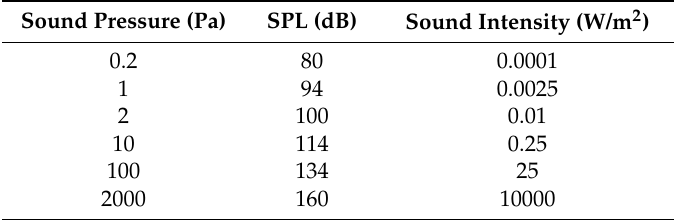
Table 1 list typical values of sound pressures and the corresponding SPL and sound intensity values. Table 1. Typical relationships of sound pressure, sound-pressure level (SPL), and sound